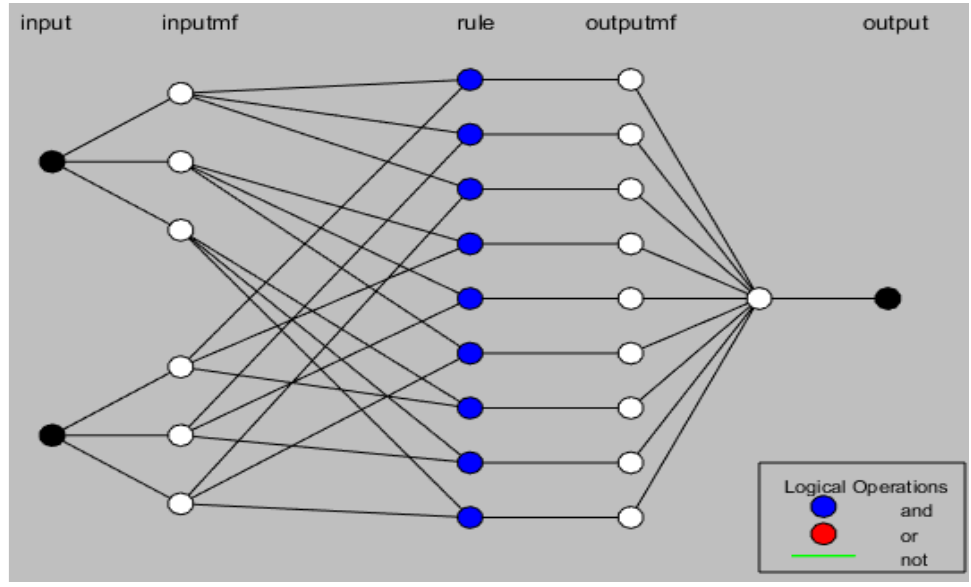
Figure 6. A typical structure of an ANFIS model showing the inputs and output.